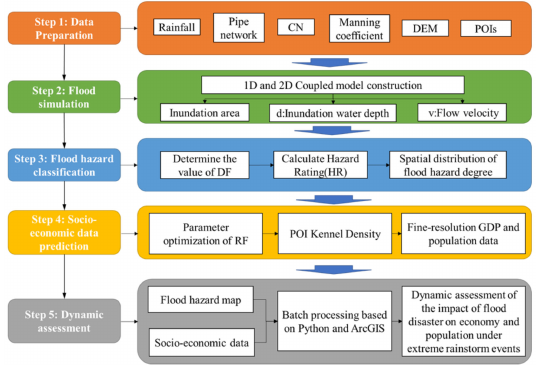
Figure 3. Overall research